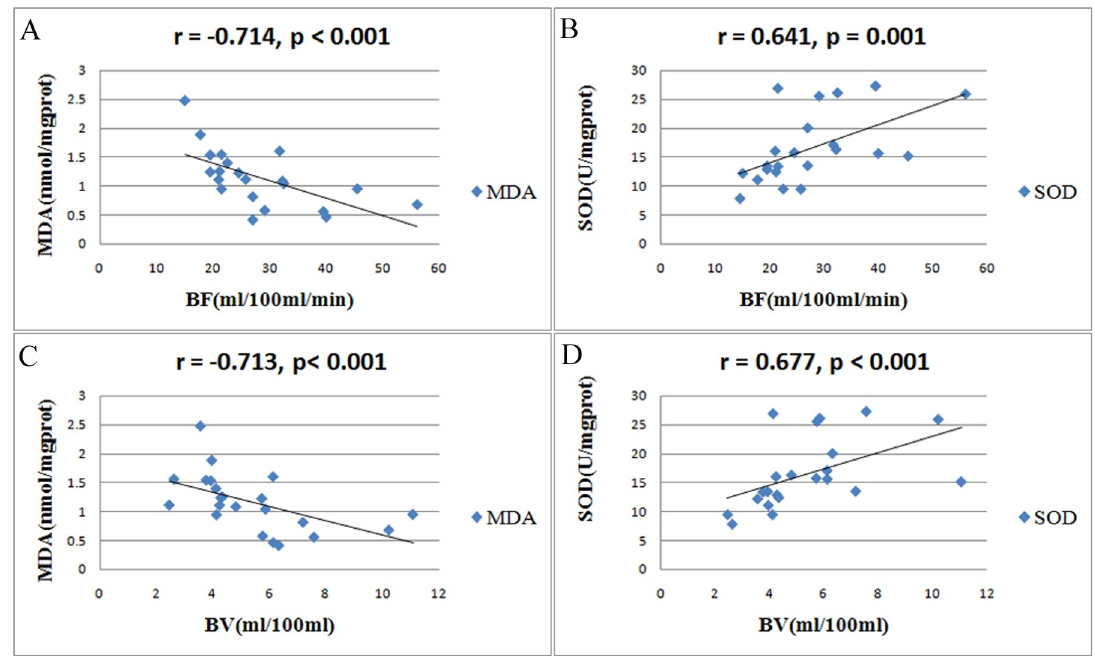
Fig 4. Correlations between the perfusion parameters and biochemical markers. (A) correlation between BF and MDA. (B) correlation between BF and SOD. (C) correlation between BV and MDA. (D) correlation between BV and SOD. Scatter plots reveal a negative correlation between BF and BV values and MDA levels, a positive correlation between BF and BV values and SOD